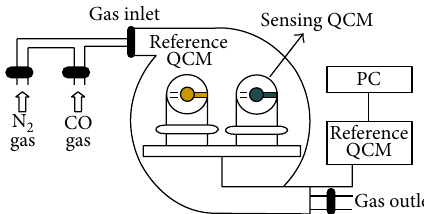
Figure 1: Schematic illustration of the experimental apparatus as QCM